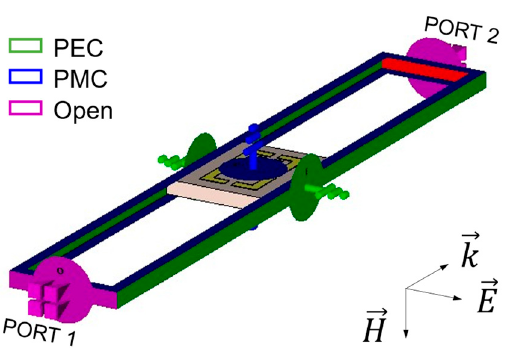
Figure 6. Schematic of the simulation model for the second design step of the L-shaped unit cell.